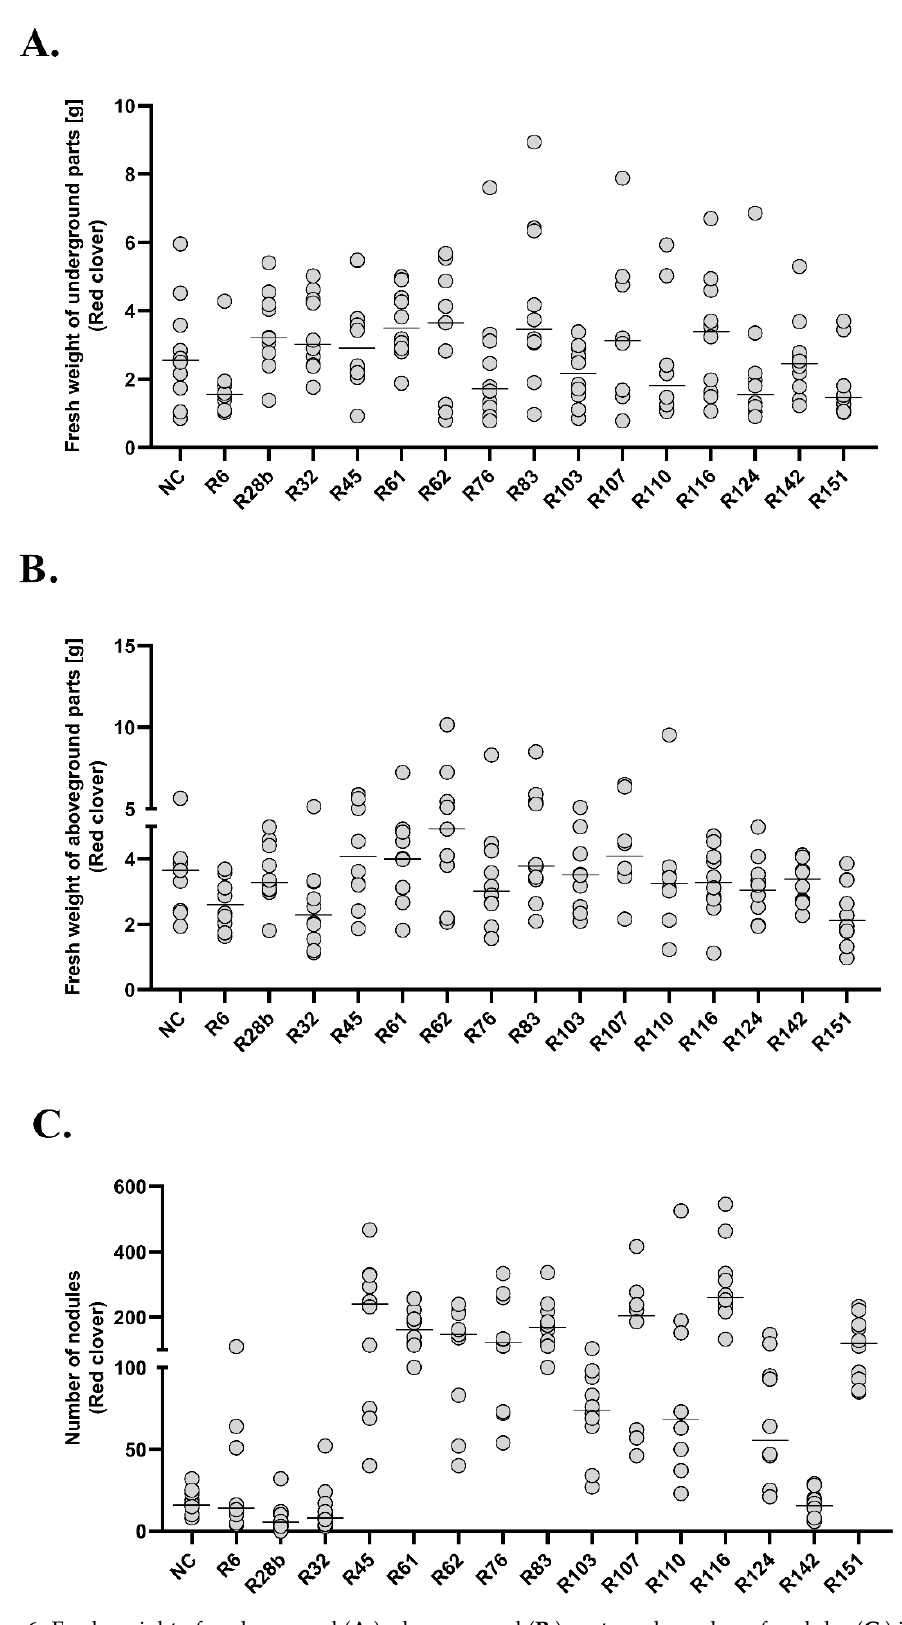
Figure 6. Fresh weight of underground ( A. ), aboveground ( B. ) parts and number of nodules ( C. ) in red clover. The diagrams show the median of results in a particular group, n = 10.